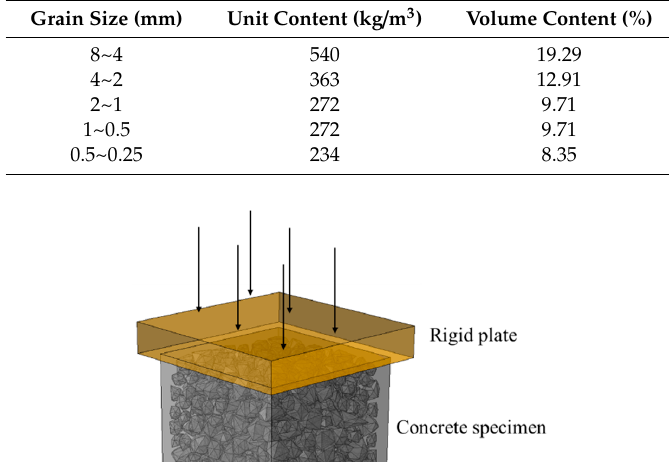
(b) Figure 8. Mesh of the concrete specimen: (a) solid elements, (b) zero thickness cohesive elements. According to the previous works about cohesive element model [28,29,30], repeated trial calculations, and the experimental results [46], the material parameters value applied in the solid elements are E = 70 GPa, v = 0.2, ρ = 2800 kg/m 3 for aggregate; E = 25 GPa, v = 0.2, ρ = 2400 kg/m3 for cement matrix. The material parameters value applied in the cohesive elements of concrete are _ n k =